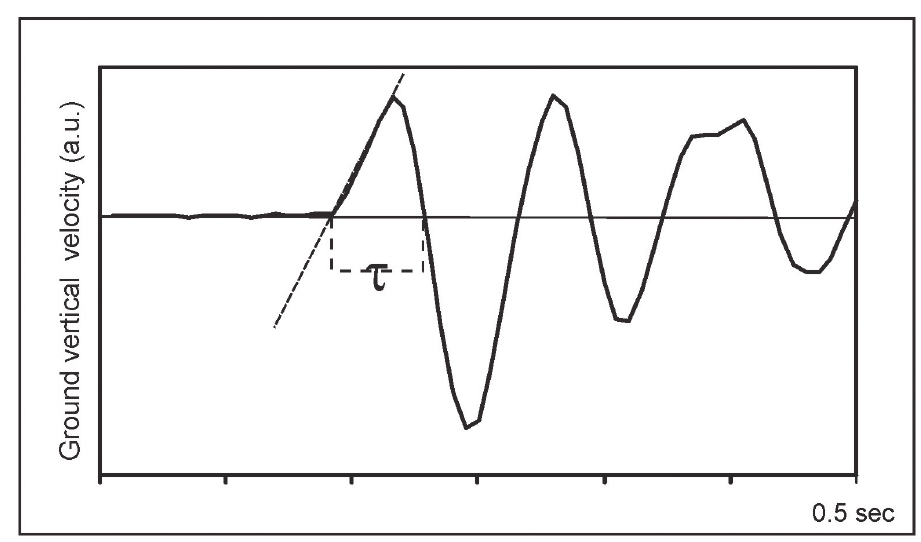
Fig. 4. Schematic picture of rise time as measured on a velocity seismogram.